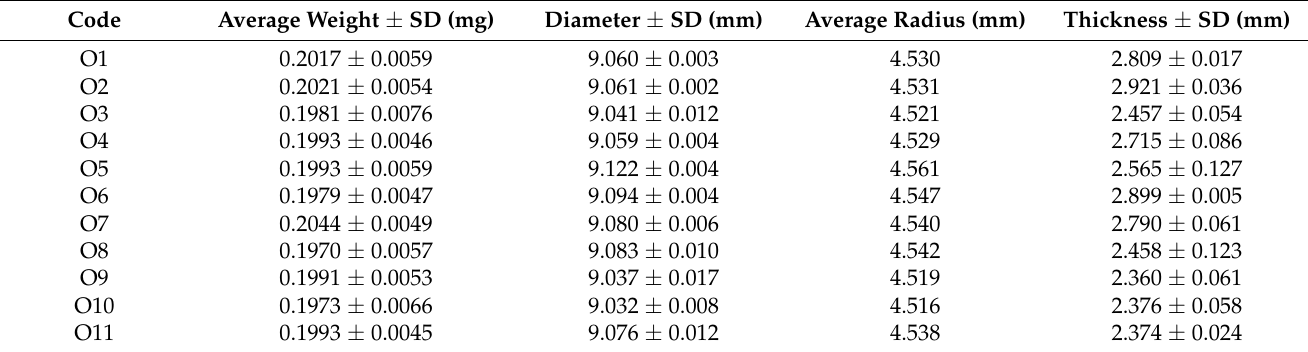
Table 5. Qualitative and quantitative dimensional parameters for O1–O11